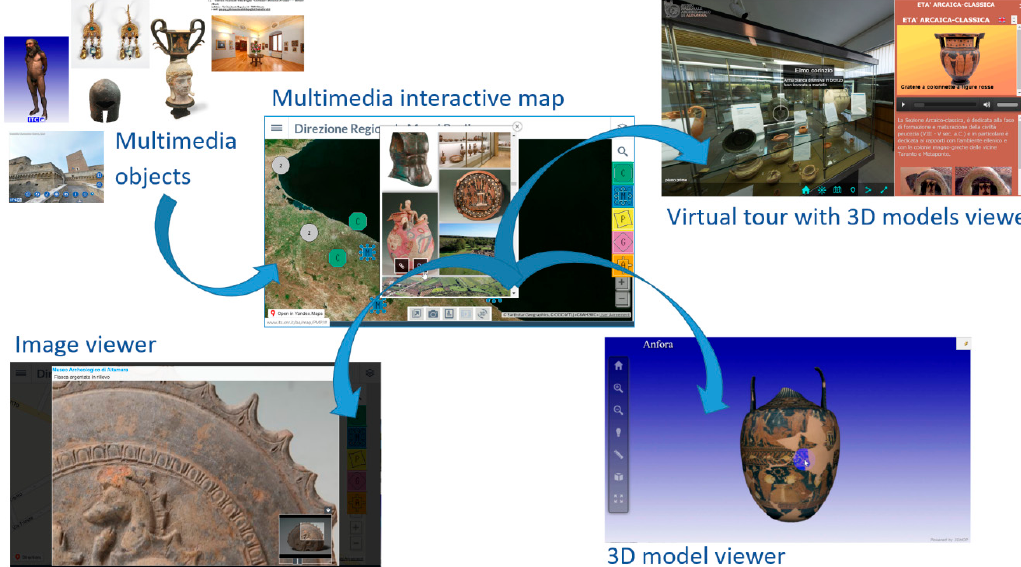
Figure 1. Virtual touring section overview: multimedia objects of museums in the map could be viewed in the map itself through their preview images and the associated applications (virtual tour, 3D model viewer, image viewer); it is also possible to access directly the virtual tour and the 3D model viewer through their own URL.